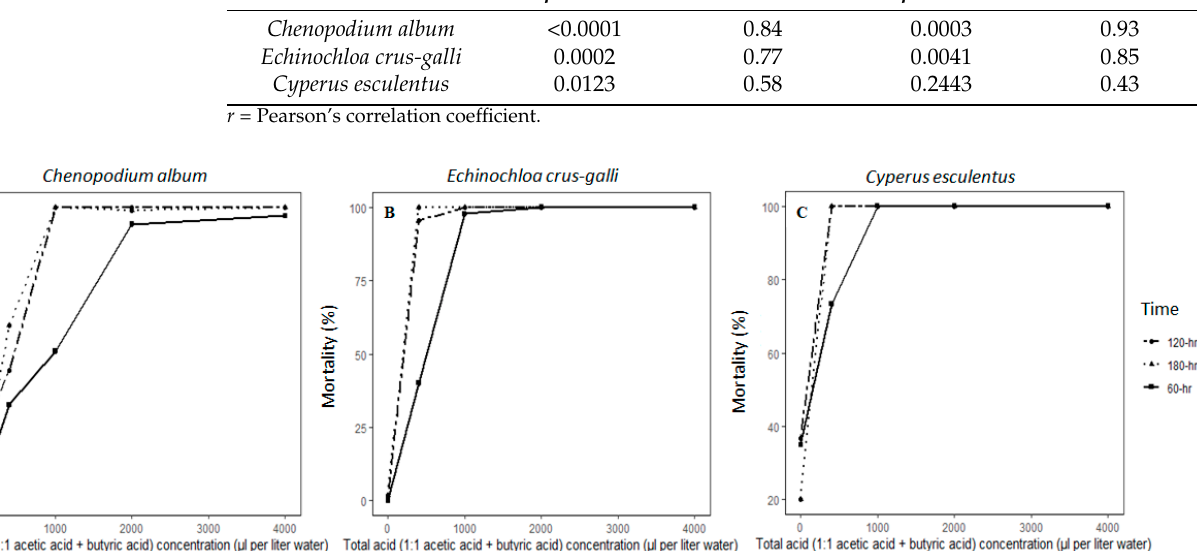
Figure 6. Effect of different concentrations of volatile fatty acids (acetic acid + butyric acid) and exposure times on propagule mortality from experiments under growth chamber conditions of ( A ). common lambsquarters ( Chenopodium album ), ( B ). barnyardgrass ( Echinochloa crus-galli ), ( C ). yellow nutsedge ( Cyperus esculentus ). Data presented are from two independent experiments, each with three replications.